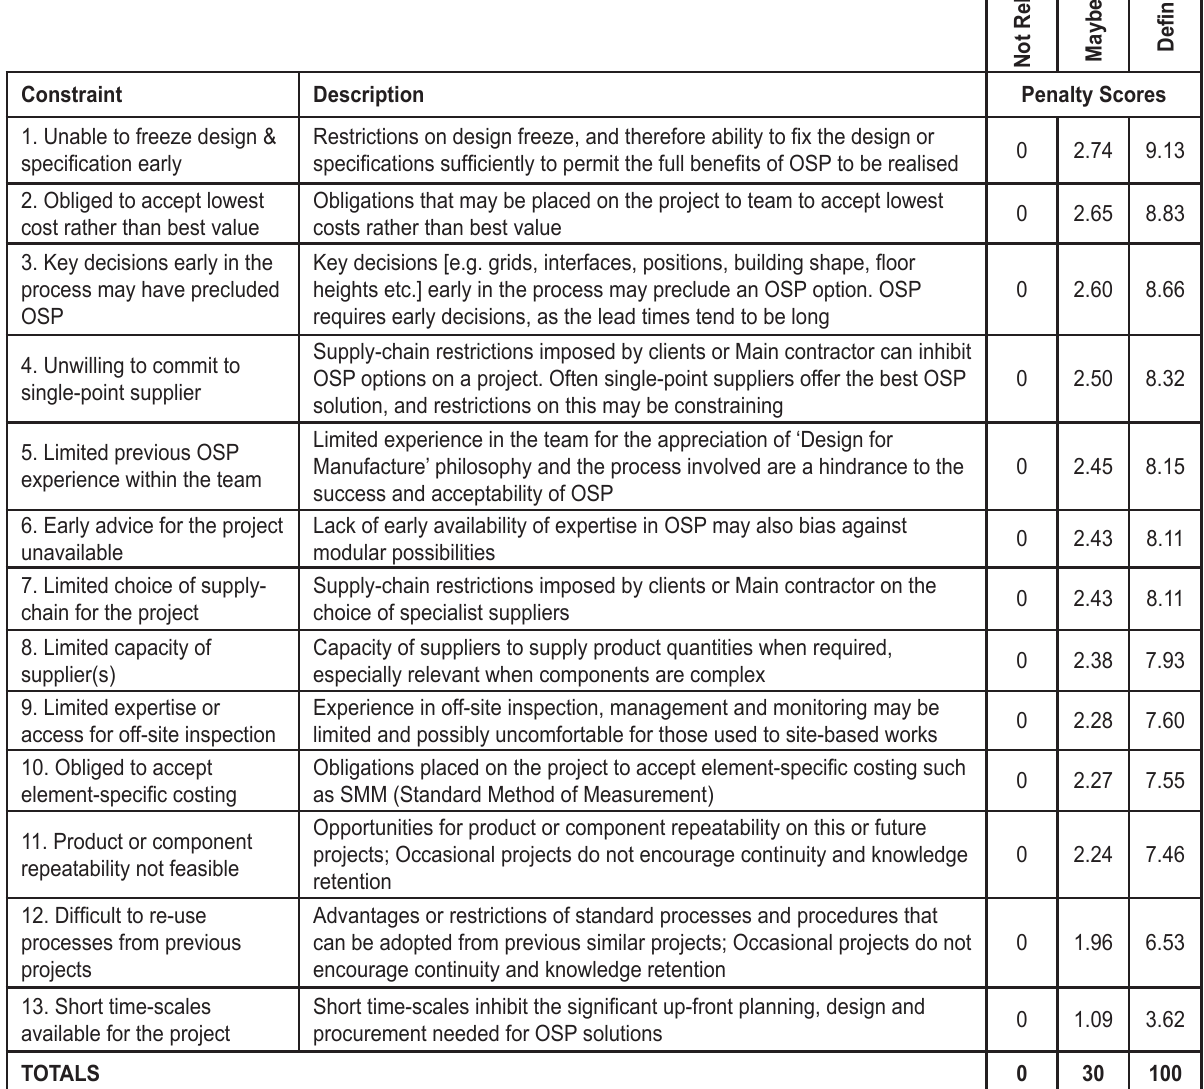
Table 4: Information and scoring system contained within the IAI A cumulative penalty score at the bottom of the table provides a quick overall assessment of the project’s OSP implementation ‘readiness’. High penalty scores would indicate that the situation would not be conducive to OSP implementation and would probably result in failure. An intuitive score assessment was used that would again encourage uncertain project teams to work